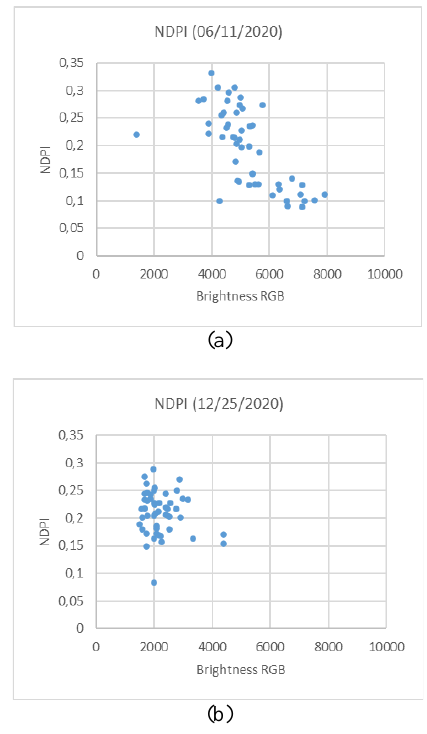
Figure 11 . Scatterplots relating NDPI and brightness values for WV3 and each PCG in (a) Summer and (b) Winter.